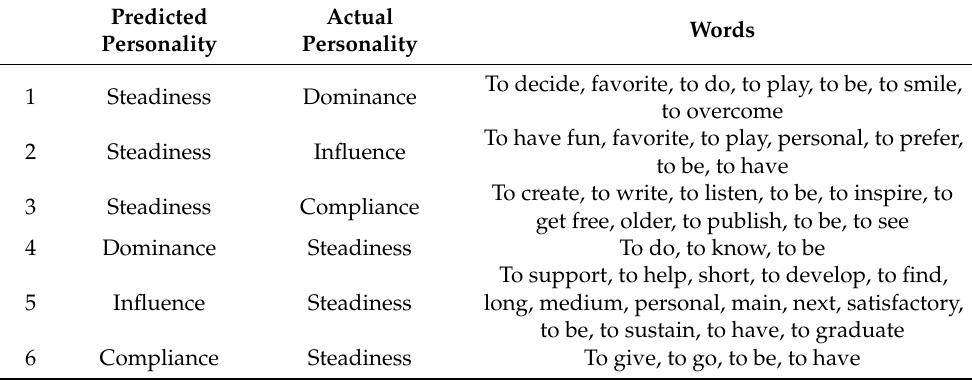
Table 15. Examples of